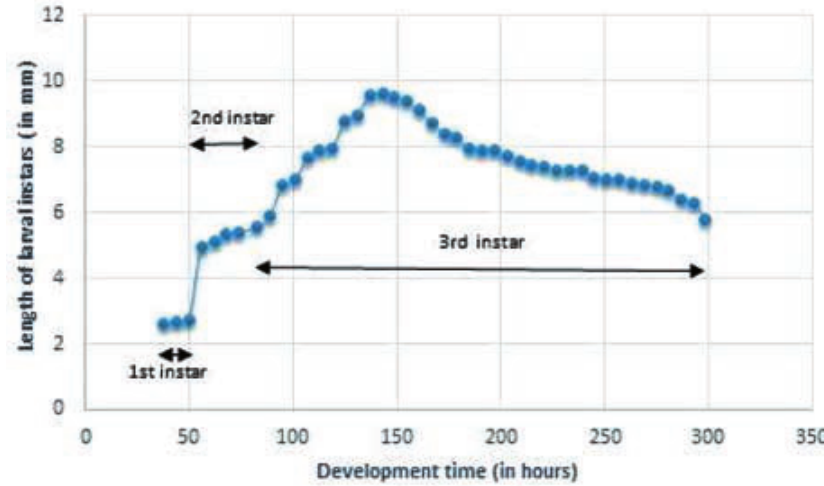
Fig.3 Relation between development time and larval length of H.ligurriens under natural conditions in Kerala,